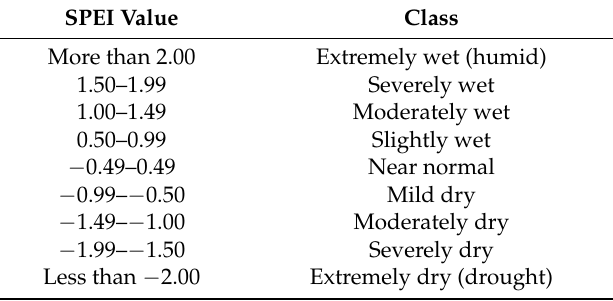
Table 1. Classification of Standardized Precipitation Evapotranspiration Index